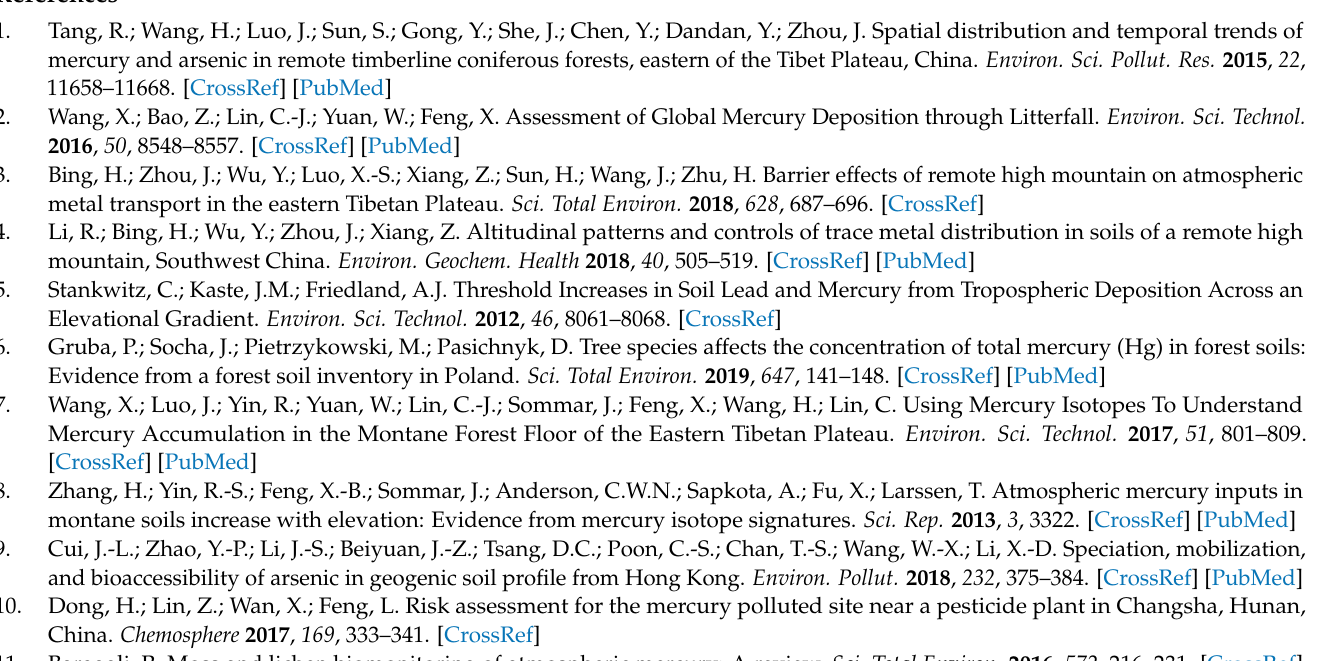
Hg, As and other parameters in surface soils. Table S3: The Pearson correlation coefficient between Hg and As in moss (M-Hg and M-As), total soil Hg and As (S-Hg and S-As) and soil properties. Table S4: The Pearson correlation coefficient between altitude and the BCF of Hg and As in plant tissues. Table S5: Enrichment factor (EF) and potential ecological risk (Er and RI) of Hg and As in